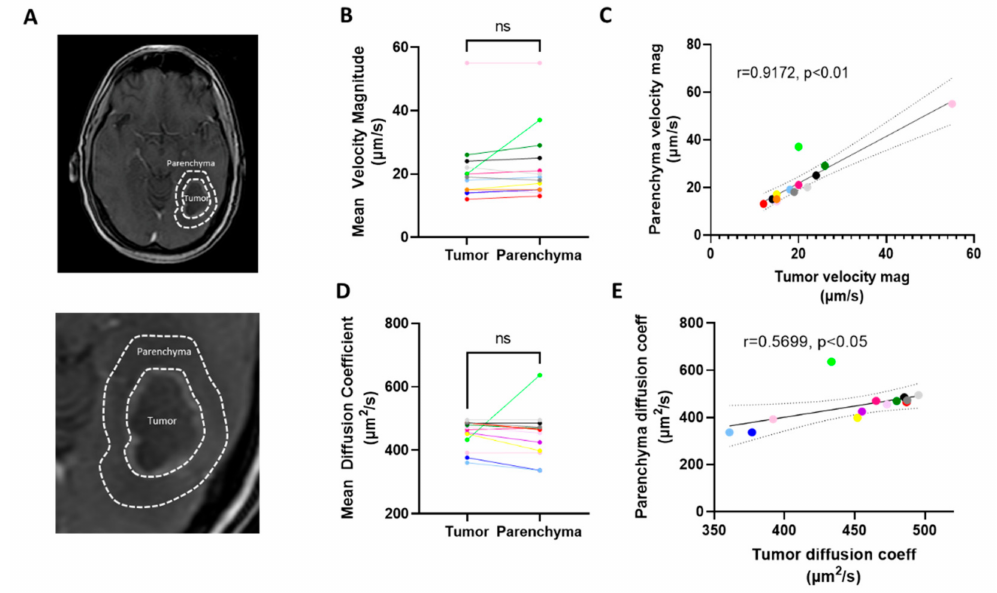
Figure 2. Transport parameters measured in the tumor vs. the surrounding parenchymal space. ( A ) Representative images of tumor (T) and parenchymal space (P) highlighted in patient W-36. ( B ) Paired data from individual patients. ( C ) Correlation of parenchymal vs tumor velocity magnitude averaged over six slices. ( D ) Mean diffusion coefficient for same regions averaged over six slices. ( E ) Correlation of diffusion coefficient by patient. Correlations are shown with a 95% CI, and colors indicate different patients and are consistent across Figure B–E. Each color represents a unique patient (see also Table S1), ns = not significant, CI = confidence